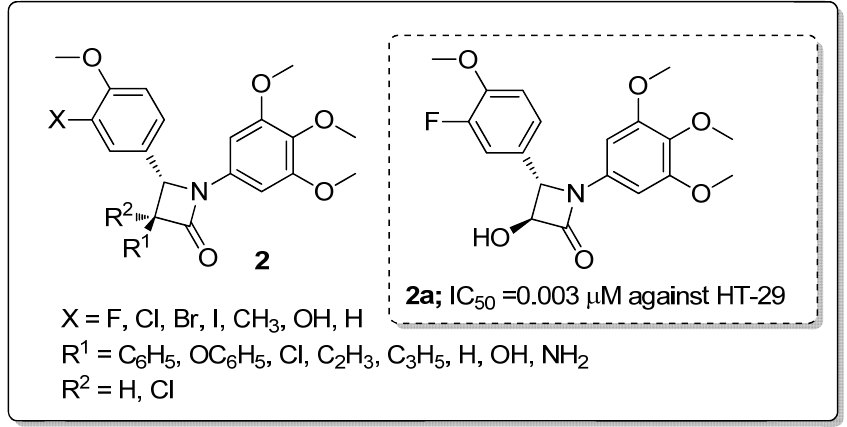
Figure 4. Antiproliferative activity of most potent β -lactam derivative 2a .